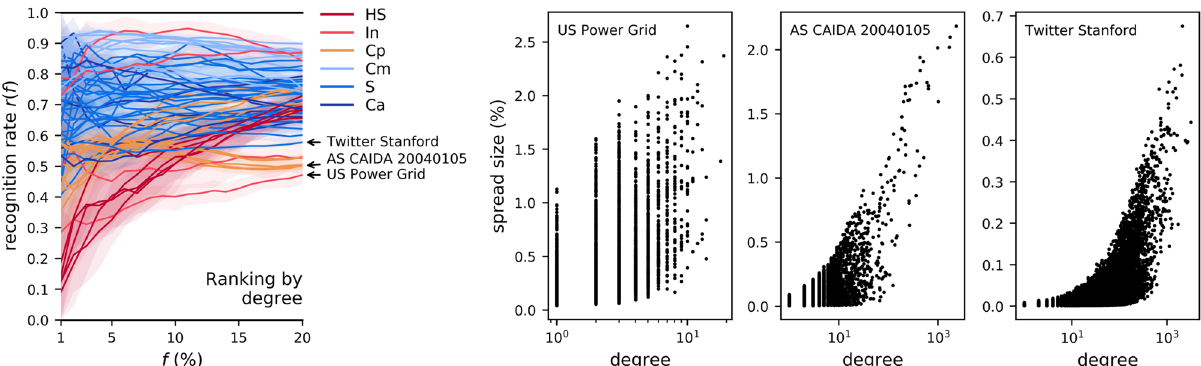
Figure 2. (left) The recognition rate by degree, across f , for all networks, at the SIR epidemic threshold. Each data line corresponds to a network, with the 95% confidence interval shown as a shaded, partly transparent area. The network categories are Ca (Coauthorship, 6 networks), Cm (Communication between people, 11 networks), Cp (Computer, 11 networks), HS (offline Human Social, 5 networks), In (Infrastructure, 4 networks), S (online Social, 23 networks). (right) Degree-influence scatterplots for three of the worst-case